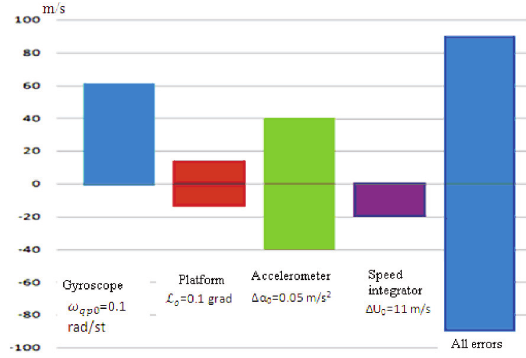
Fig. 4. The maximum error of one channel of an inertial system of distance for various cases of failures of structural elements